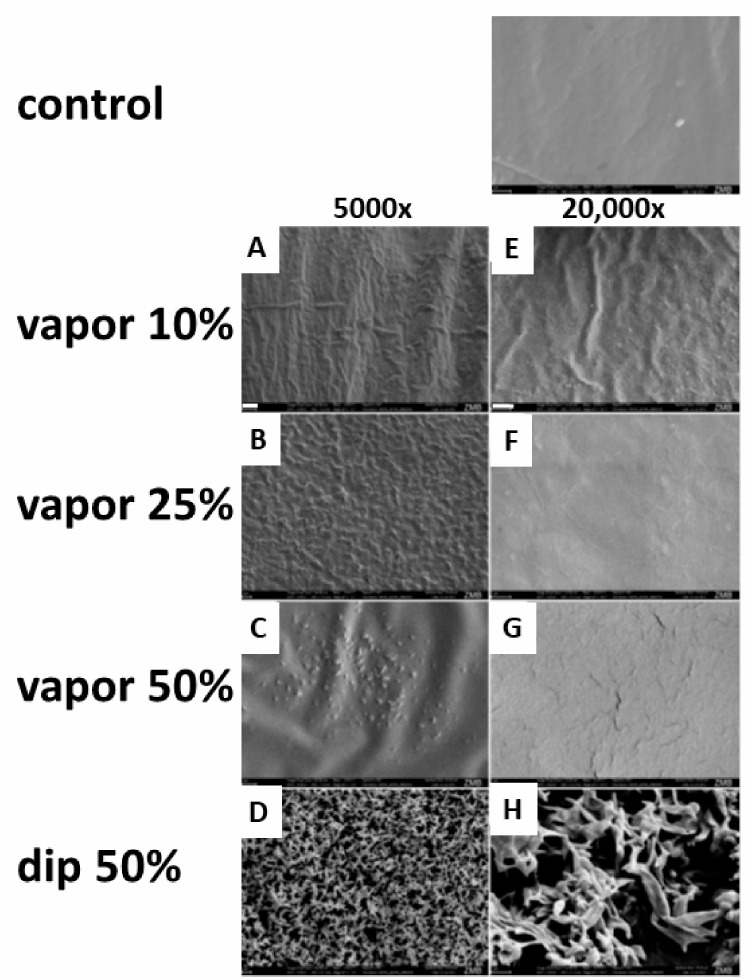
Figure 3. SEM images of native control and DMA-loaded membranes. Control: the surface of an untreated, nativemembraneisdisplayedat20,000 × magnification. ( A – D )Imagesat5000 × magnification (white scale bar in A represents 2 µ m for the entire column), ( E – H ) images at 20,000 × magnification (white scale bar in E represents 1 µ m for the entire